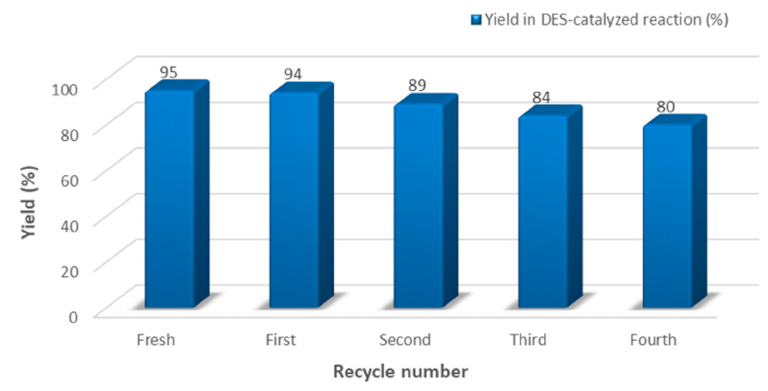
Figure 2. Recyclability of DES. Isolated yields from reaction in the ChCl–urea mixture at 60 °C.